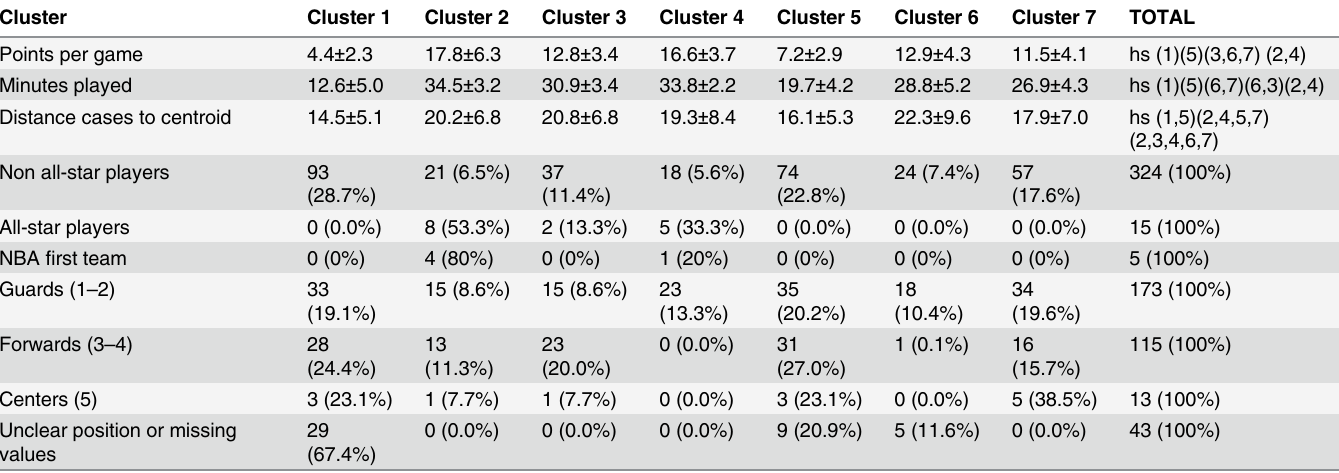
Table 3. Player distributions in the seven clusters contrasted against player category, NBA first team and player specific court